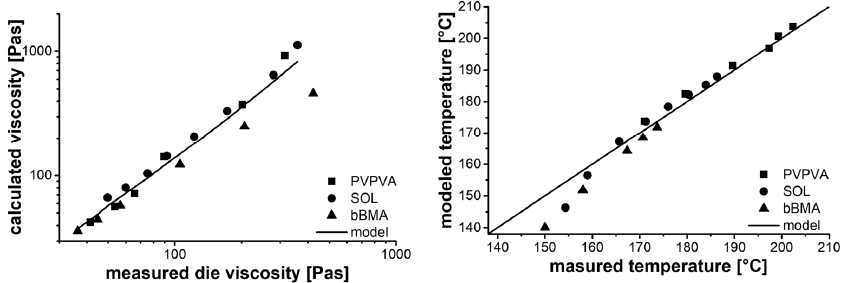
Figure 6. Results of autogenic extrusion experiments. Correlation between die viscosity and calculated viscosity ( left ), comparison of measured and predicted melt temperature ( right ).